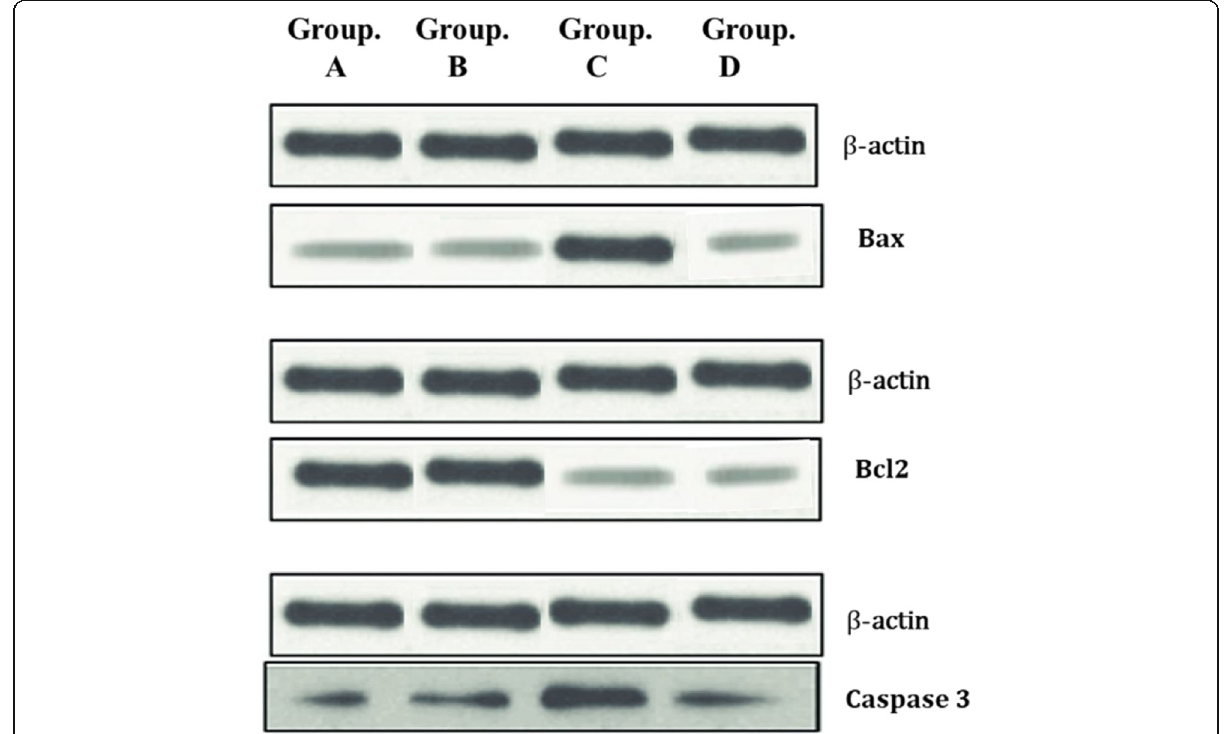
Fig. 2 Gene expression levels were assessed in the lung of control and experimental